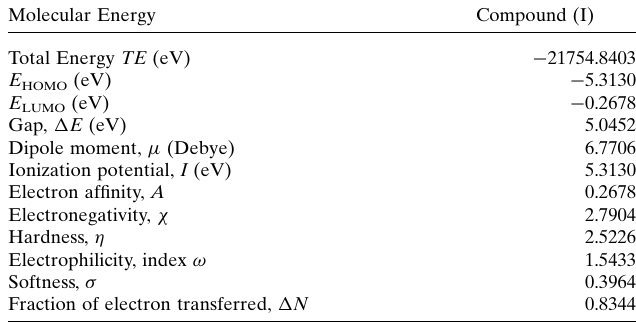
Table 3 Calculated